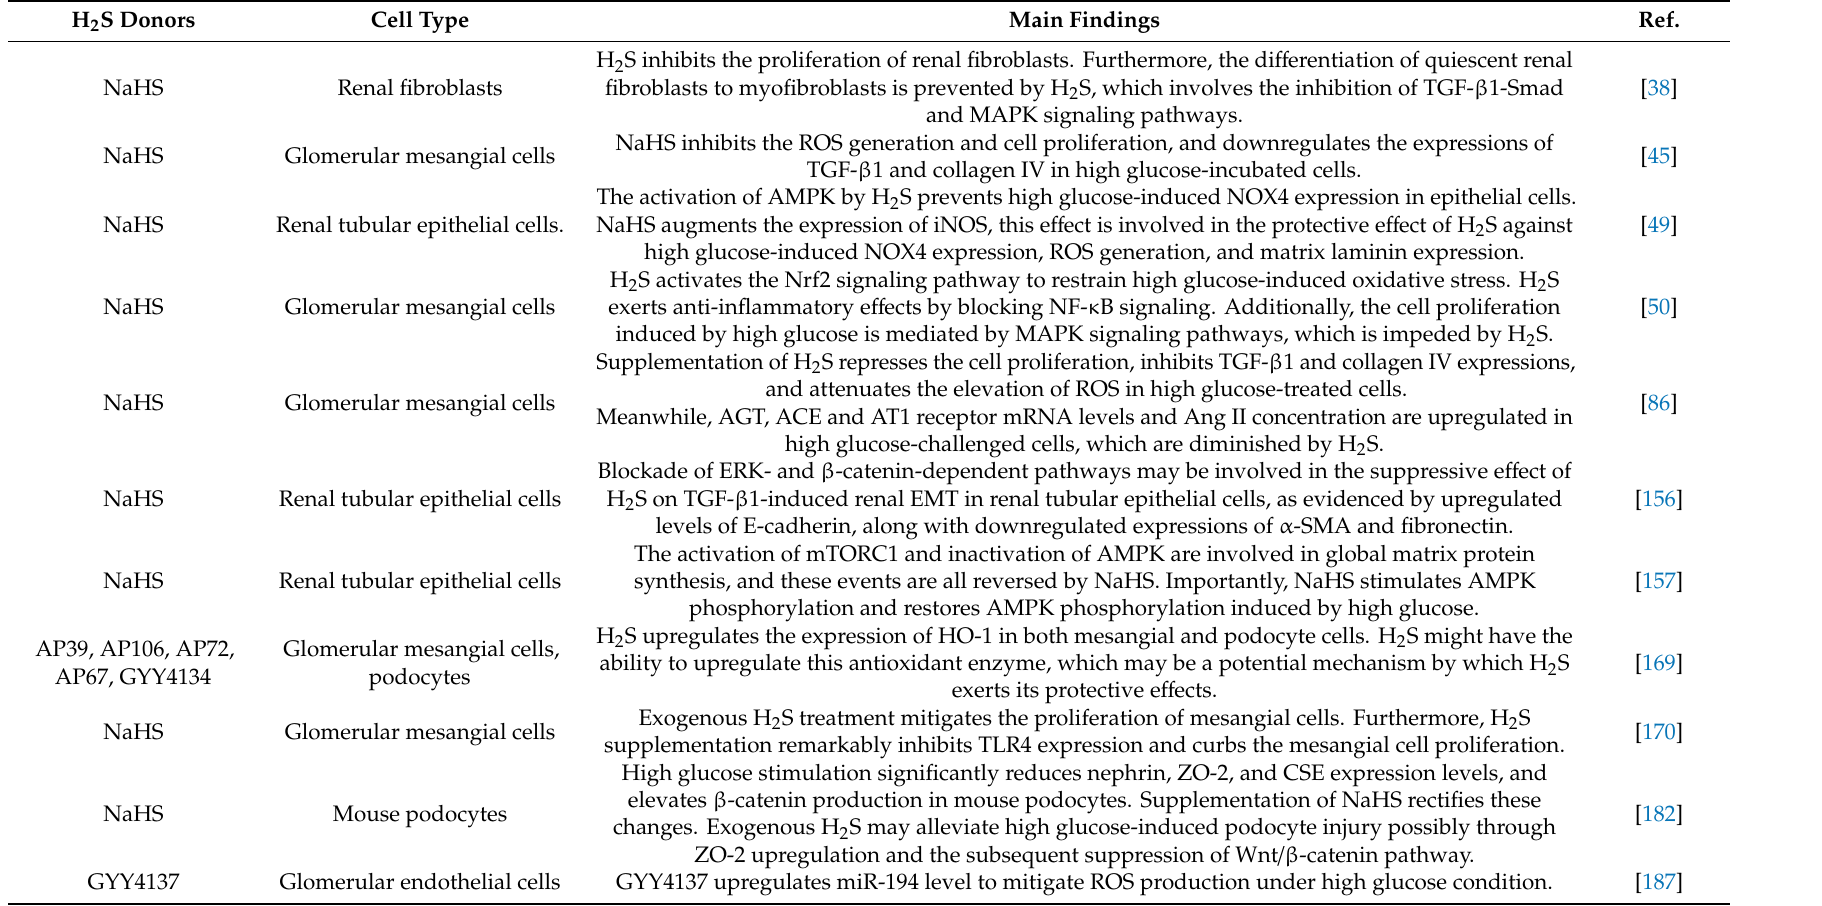
Table 1. Beneficial e ff ect of H 2 S on experimental diabetic nephropathy in